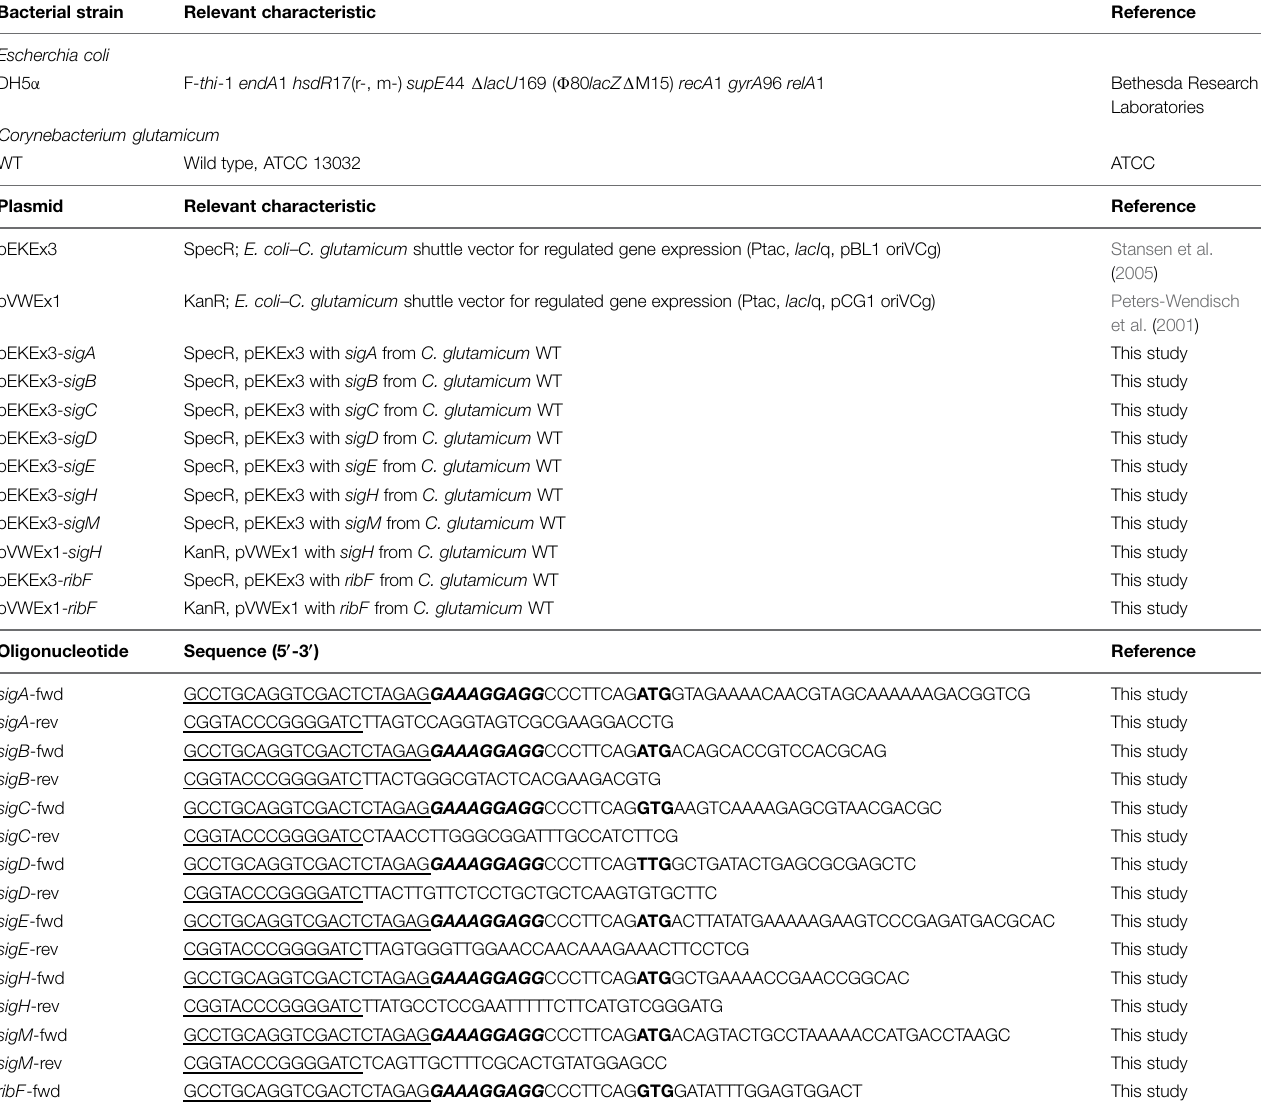
TABLE 1 | Bacterial strains, plasmids and oligonucleotides used in this study. Bacterial strain Relevant